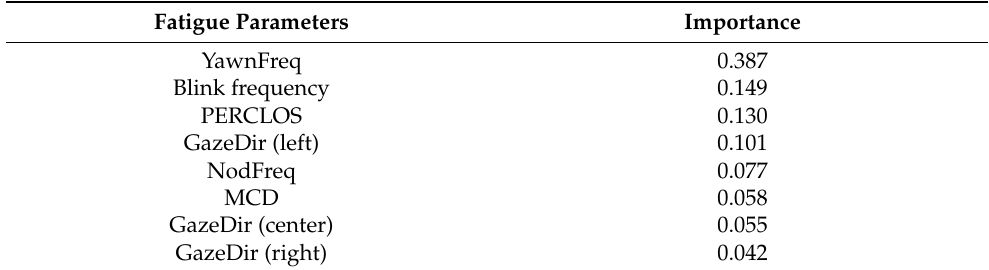
Table 3. Importance of the fatigue parameters.